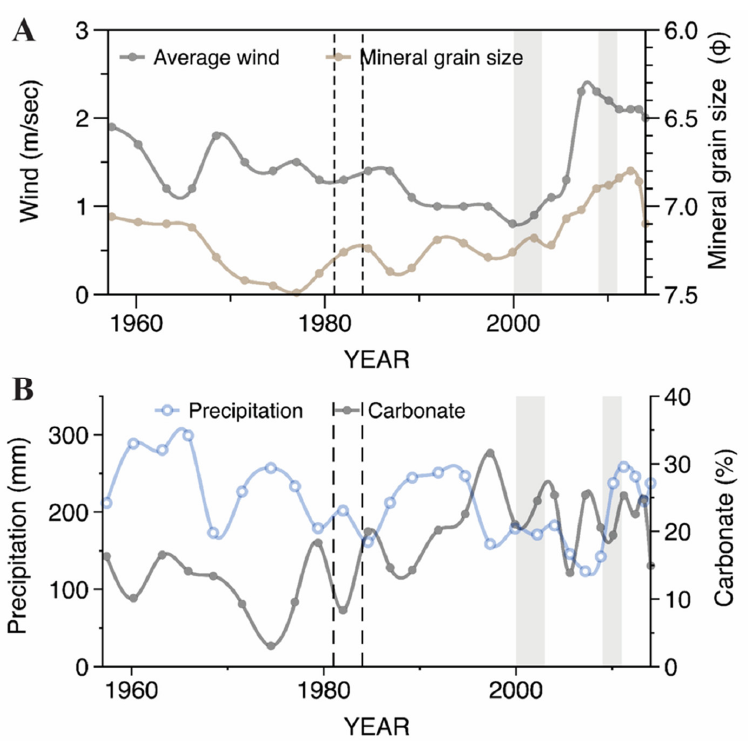
Figure 8. Comparison between meteorological data and sediment characteristics of Boontsagaan Lake. ( A ) Wind versus mineral grain size and ( B ) precipitation versus carbonate. The drought combined with the dzud record is covered with a dashed line, and the white dzud is highlighted in